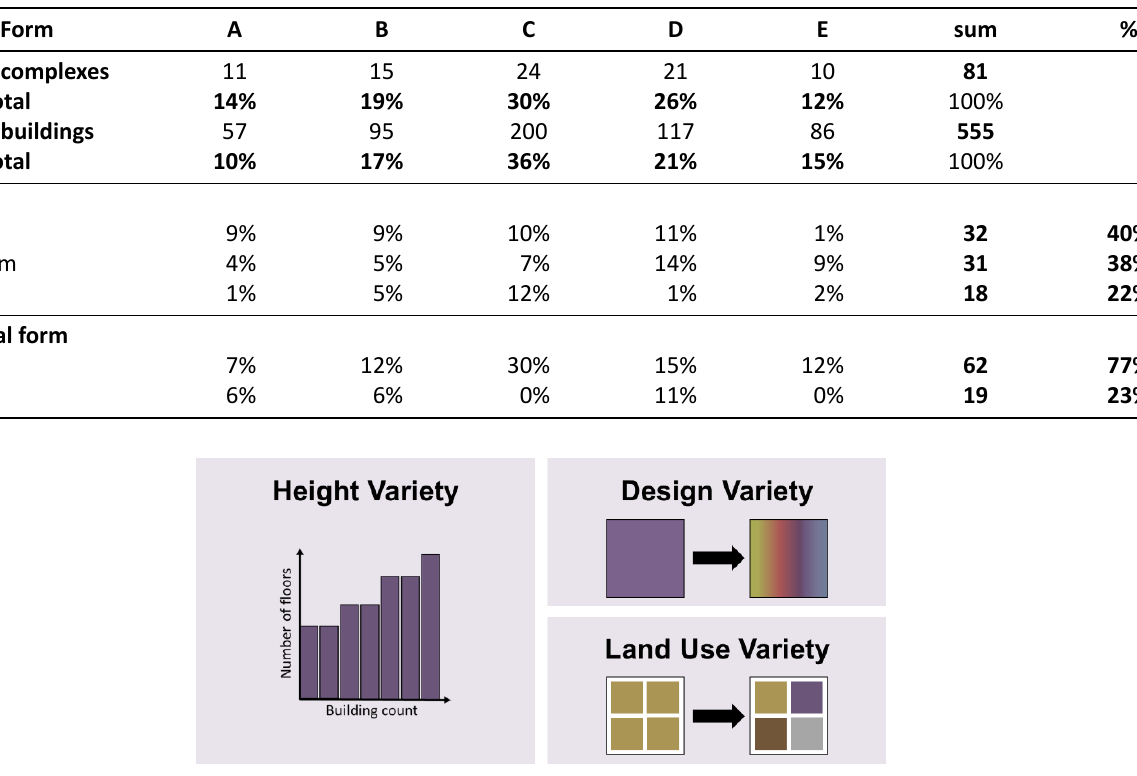
Figure 2. HRHCs morphological matrix scheme. Table 1. The classification matrix of complexes.